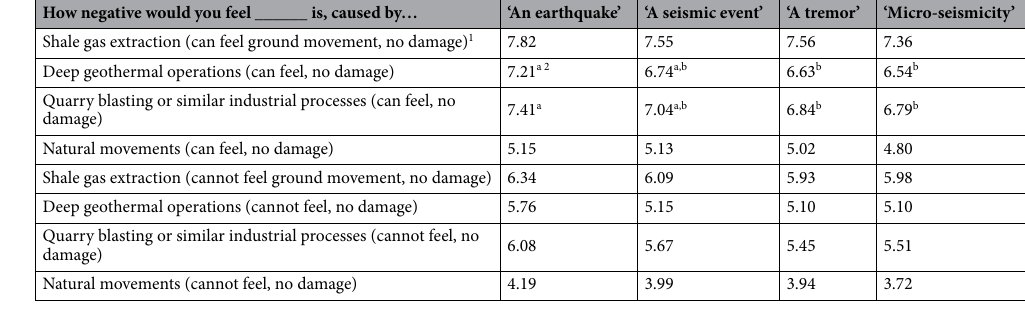
Table 4. Wave 3 survey: perceived negativity of seismicity of events, based on framing and cause of the event. 1 All items in this table were measured on an eleven-point scale, 0 = not at all negative, 10 = very negative. 2 Within a given row, superscript letters denote values that differ from each other significantly, based on Tukey post-hoc tests for differences between means, following an ANOVA. If the letter is the same, those mean values do not differ. If a row has no superscript letters, there are no significant differences amongst the four means for that